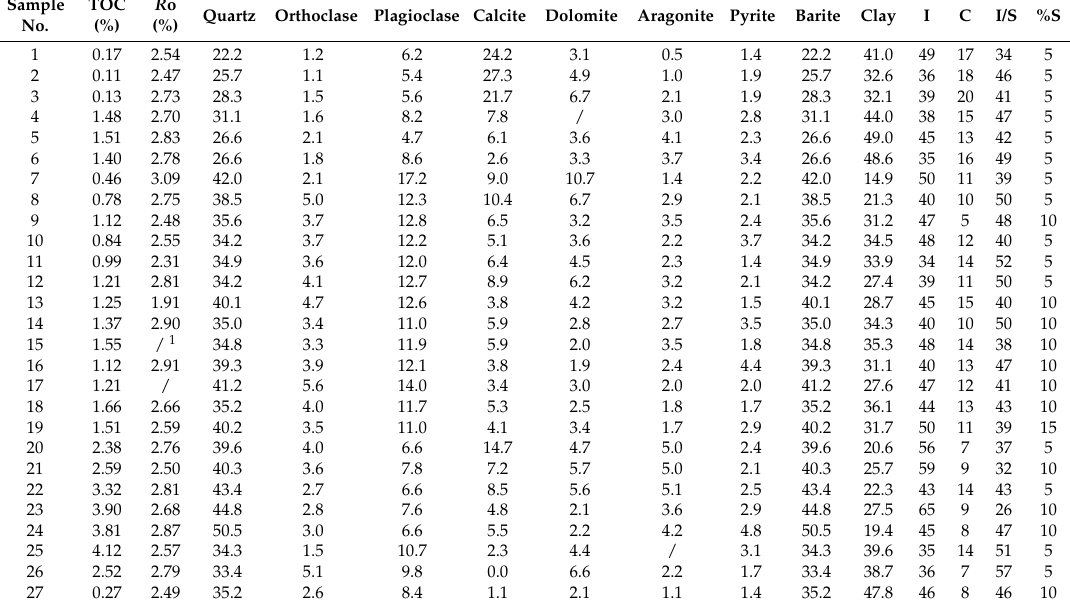
Table 2. The results of total organic content (TOC), maturity, and mineralogical composition of the samples. Sample No.